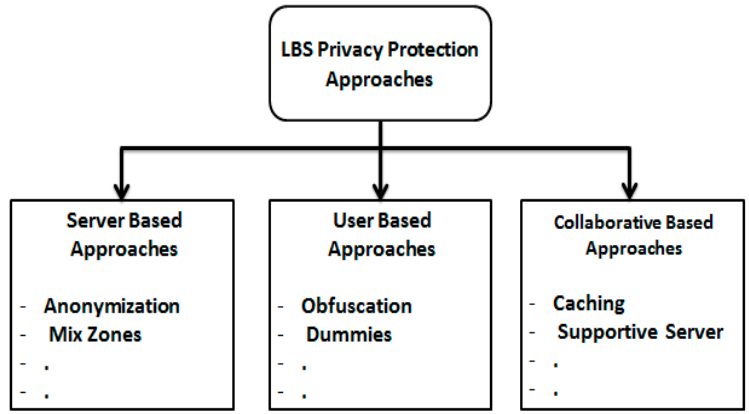
Figure 2. Classification of LBS privacy protection approaches.